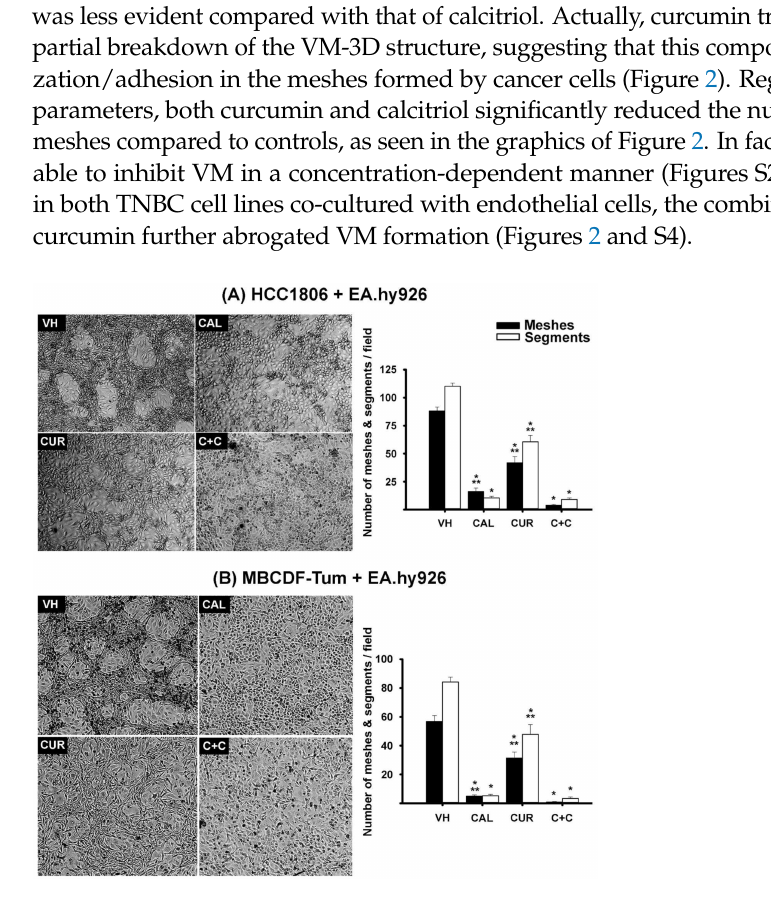
Figure 2. Calcitriol and curcumin inhibited endothelium-induced TNBC-VM capacity in co-cultures. EA.hy926-induced VM was observed in co-cultures of HCC1806 ( A ) and MBCDF-T ( B ) cells incubated with vehicle (VH, ethanol). The presence of calcitriol (CAL, 10 nM) changed cell morphology from spindle-shape to cobblestone-like and abrogated VM formation, while curcumin (CUR, 20 µ M) affected the 3D VM structure. The combination of calcitriol with curcumin (C+C) further inhibited VM in both TNBC cells. The number of meshes and segments per visual field were counted by three different observers in hot spots in at least 10 different photographs, considering 3 different experiments for each cell line. The graphics depict the average number of meshes and segments per visual field. * p < 0.001 vs. VH. ** p < 0.01 vs. C+C. Magnification is 10 ×